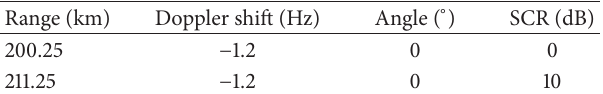
Table 2: Mutitargets situation.